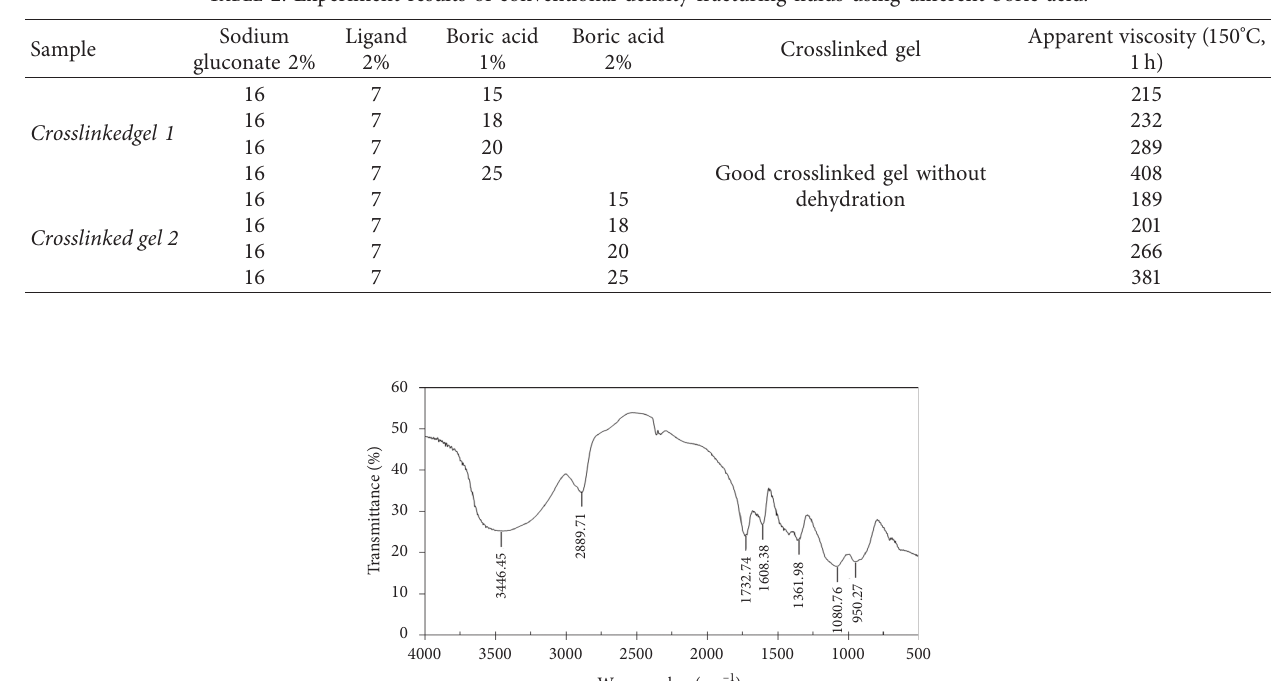
Table 2: Experiment results of conventional density fracturing fluids using different boric acid.